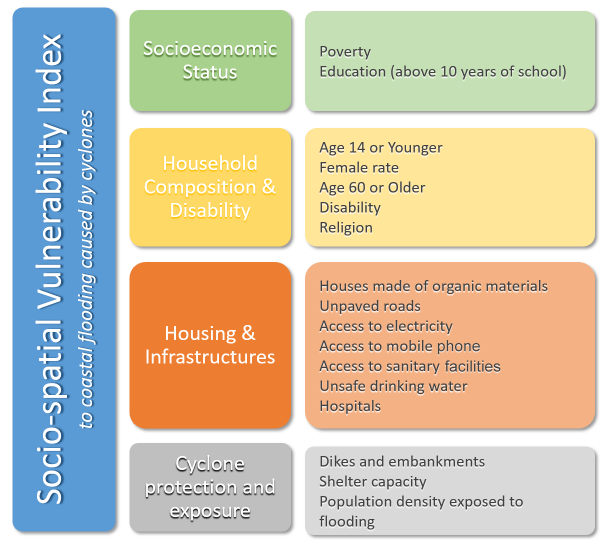
Figure 2. Socio-spatial vulnerability index scheme (adapted from Flanagan et al.,